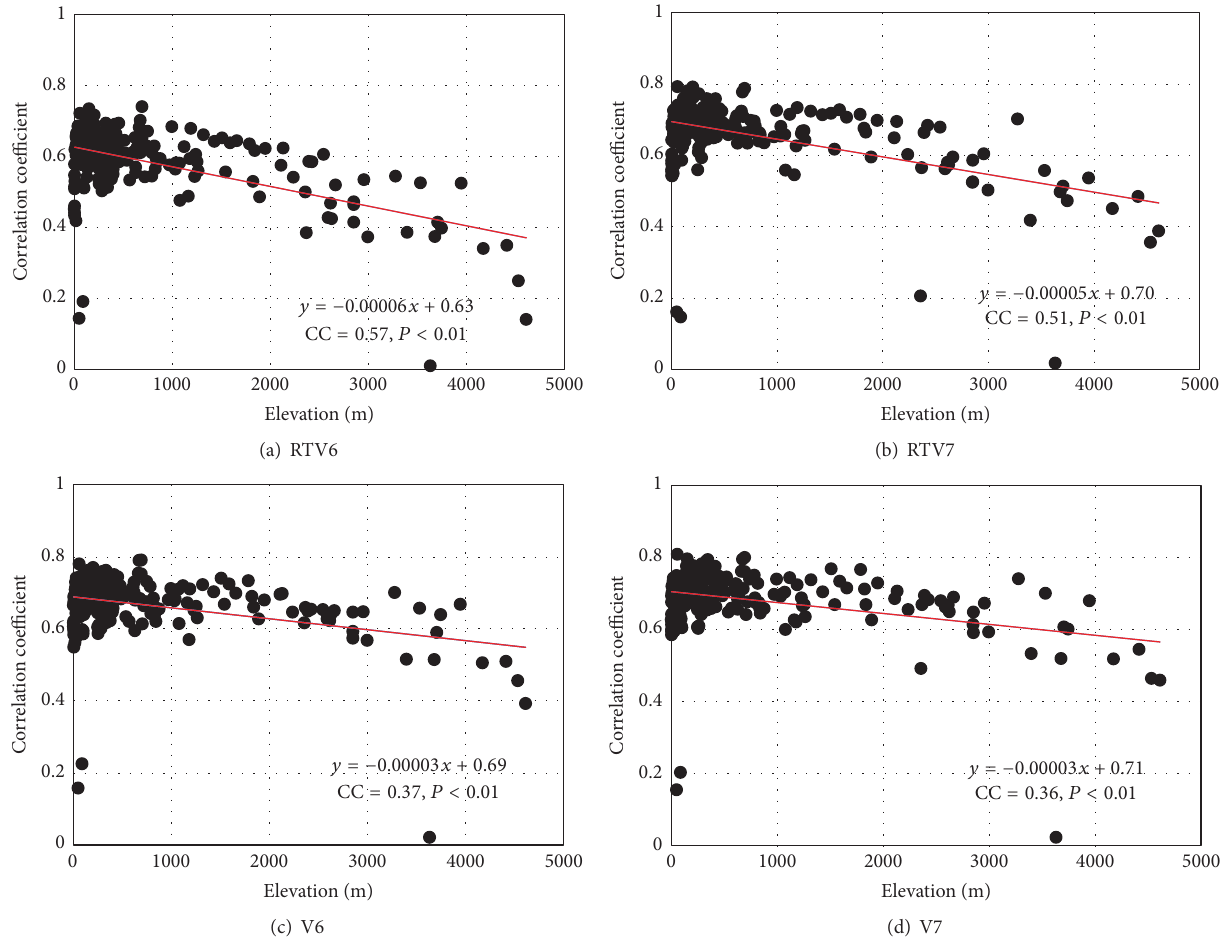
Figure 8: The correlativity between elevation and correlation coefficient of TRMM precipitation and observed data.